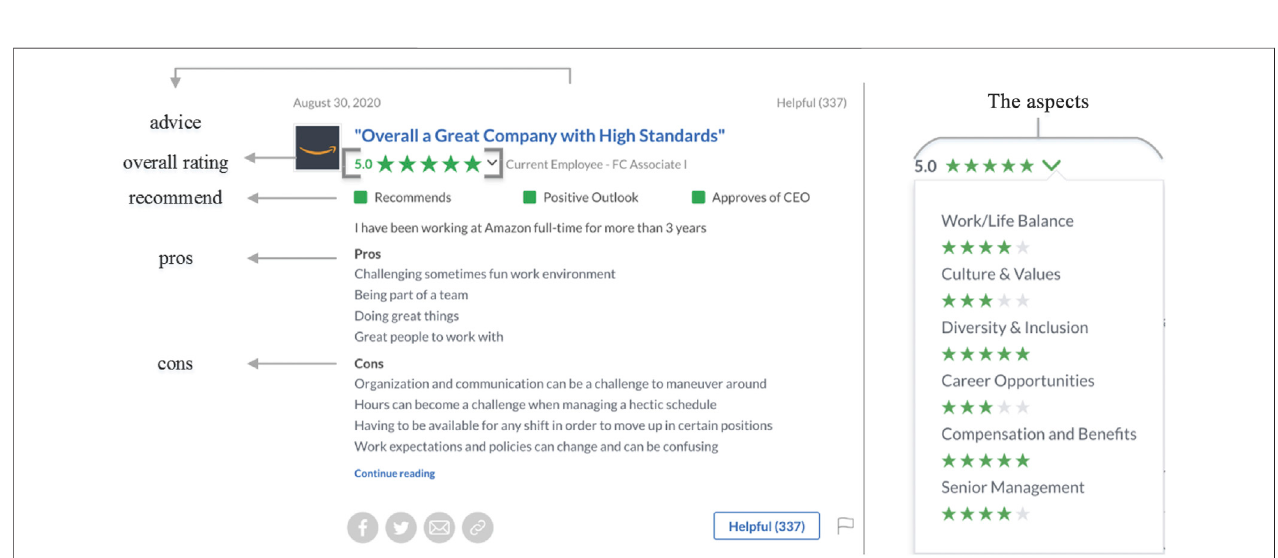
FIGURE 2 | The fl ow chart of the joint model for extracting latent aspects and their ratings from online employee reviews.